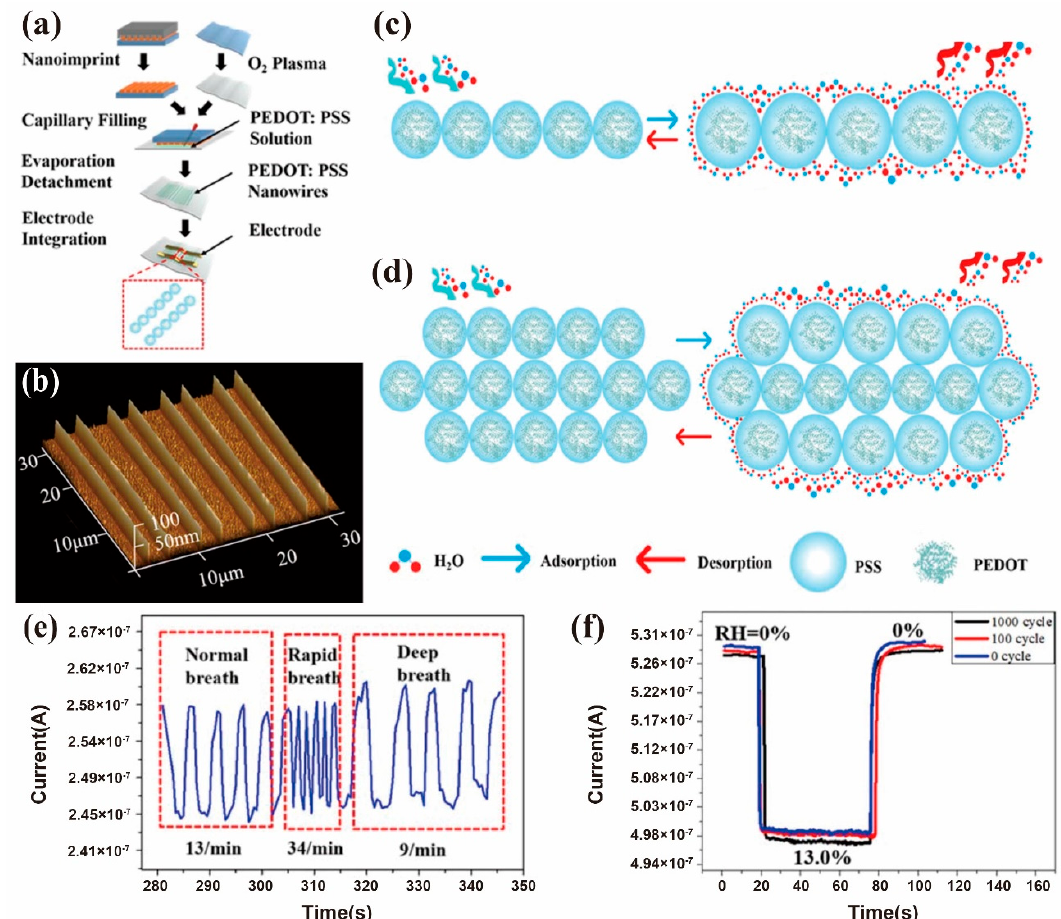
Figure 8. ( a ) The fabrication process of PEDOT:PSS nanowire sensors; ( b ) optical microscopy image of the PEDOT:PSS nanowires; schematic of water adsorption and desorption on ( c ) PEDOT:PSS nanowires and ( d ) PEDOT:PSS film; ( e ) the response of the humidity sensor to normal, rapid, and deep respiration; ( f ) response of the humidity sensor under RH switching between 0% and 13% with multiple bending cycles at an outer bending radius of 10 mm [67].